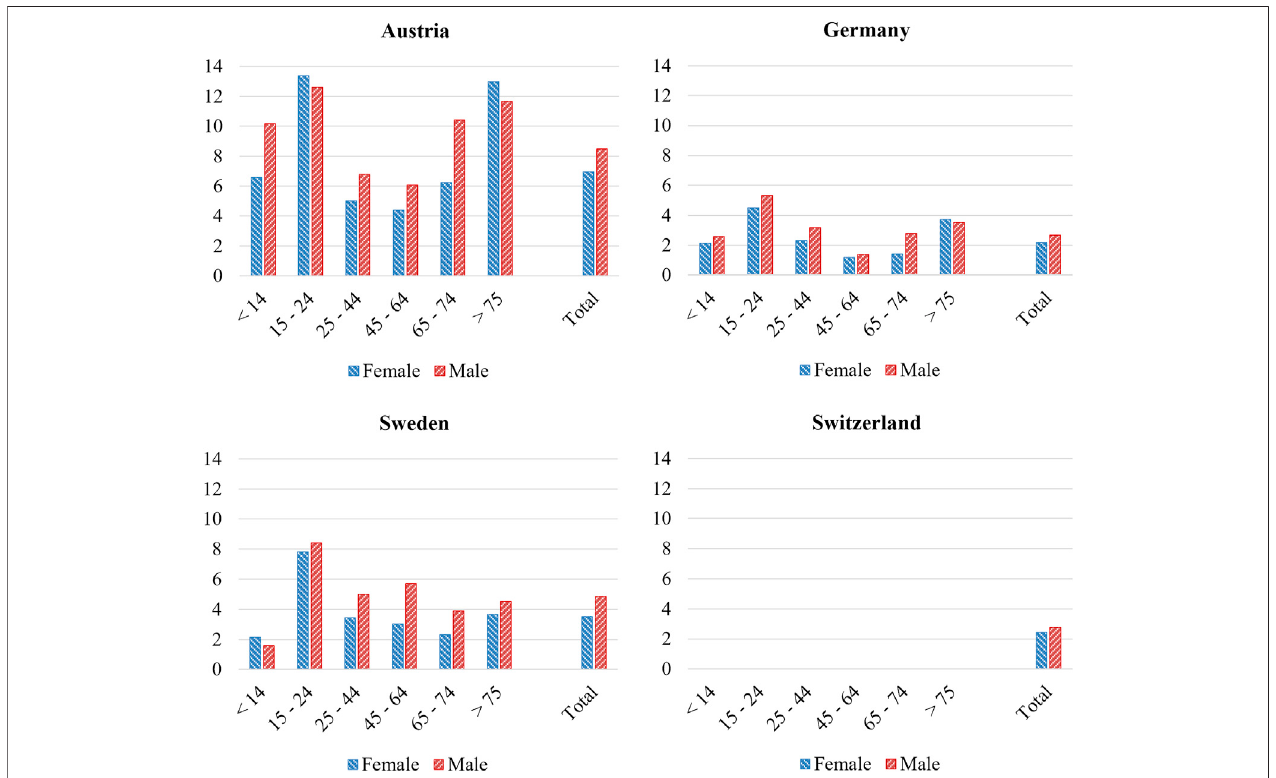
FIGURE 6 | Incidence of injured pedestrians classi fi ed by age and gender.